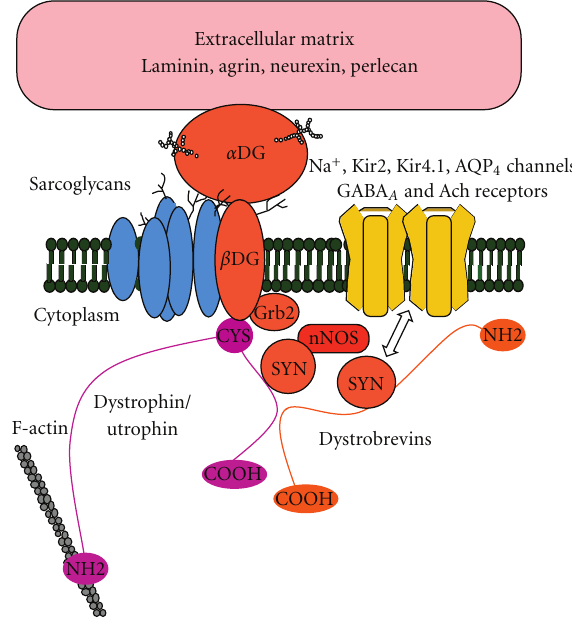
Figure 2: Organization and composition of the dystrophin/utro- phin-associated glycoprotein complexes (DGC/UGC) . The NH2- terminus of dystrophins and utrophins (purple) binds to cytoskele- tal filamentous actin (F-actin) while the cysteine-rich and COOH domains interact with the di ff erent DGC/UGC components. The cysteine-rich domain binds the dystroglycan subcomplex com- posed of transmembrane β -dystroglycan ( β -DG) and extracellular α -dystroglycan ( α -DG). The β -dystroglycan may interact with the sarcoglycan-sarcospan subcomplex (blue) and with signaling protein such as Grb2. The α -DG is a glycosylated receptor for extracellular matrix proteins, such as laminin, agrin, perlecan, and neurexin depending on tissue- and cell-specific expression. The COOH-terminus of dystrophins/utrophins binds the cytosolic proteins syntrophins and dystrobrevins. Dystrobrevins associate with syncoilin, dysbindin, and syntrophins (SYN). Syntrophins contain a PDZ domain enabling associations of the DGC with a variety of proteins including signaling and synaptic proteins, such as neuronal nitric oxide synthase (nNOS) or neuroligins, as well as several transmembrane channels (AQP-4, potassium Kir2 and Kir4.1, and voltage-gated sodium channels) and receptors (AchR, GABA A